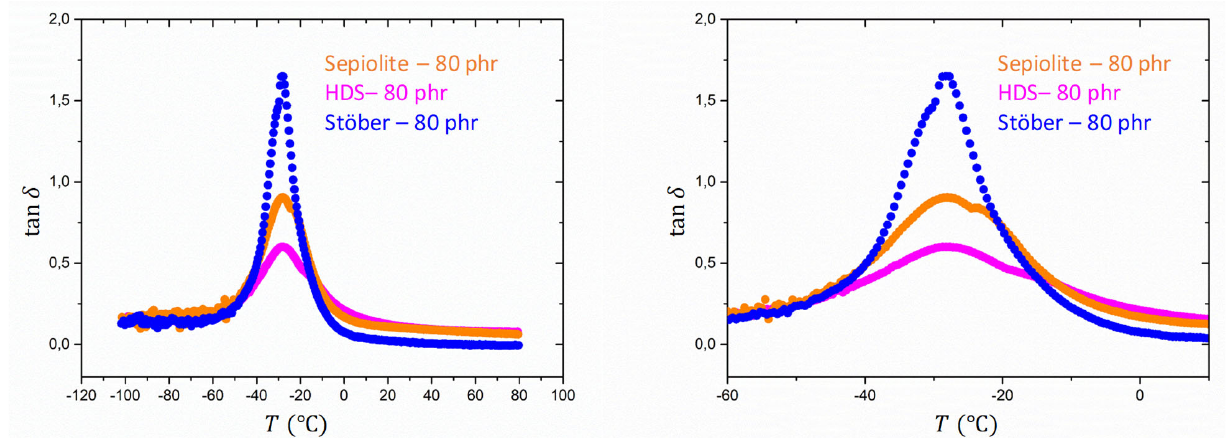
Figure 5. Evolution of tan δ for reference 80 phr SBR samples filled with Silica HDS-80 phr (magenta), Sepiolite-80 phr (orange) and Stöber-80 phr (blue).